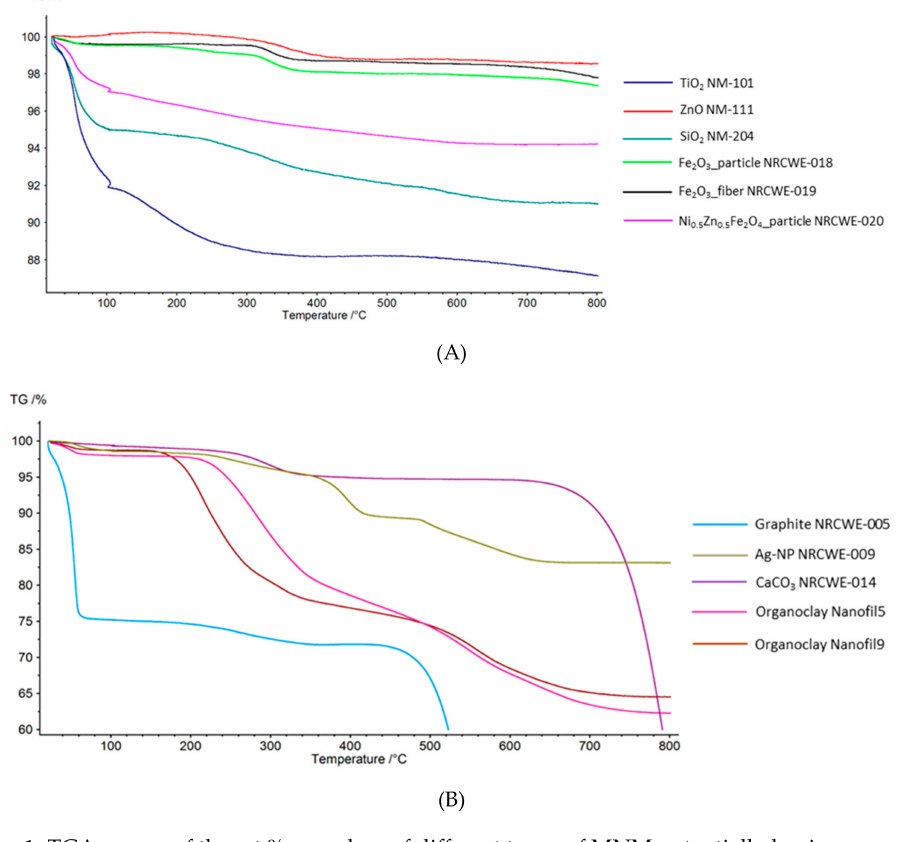
Figure 1. TGA curves of the wt.% mass loss of di ff erent types of MNM potentially having an organic coating. ( A ) TGA curves that fit into a relative mass range of 86–100 wt.%, ( B ) TGA curves for MNM with large mass loss. The small negative peak at 100 ◦ C is due to the mass loss during the 10-min period of the TGA program with constant 100 ◦